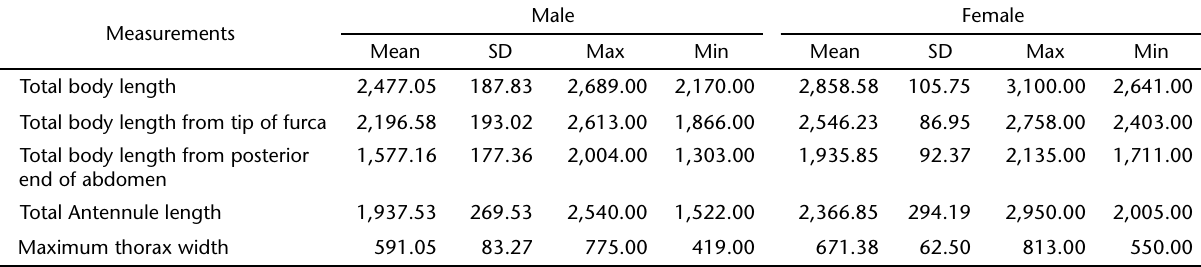
Table II. Measurements (µm) of males and females of Argyrodiaptomus bergi from the Brazilian population. Measurements